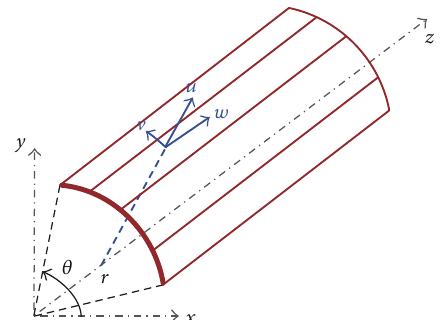
Figure 2: Diagram of the displacements 𝑢, V , 𝑤 of a volume element in a hollow cylindrical tube with radius 𝑟 . The tube axis is parallel to the 𝑧 axis, which is vertical to the tube’s cross-section with thickness ℎ that lies in the 𝑥 - 𝑦 plane.